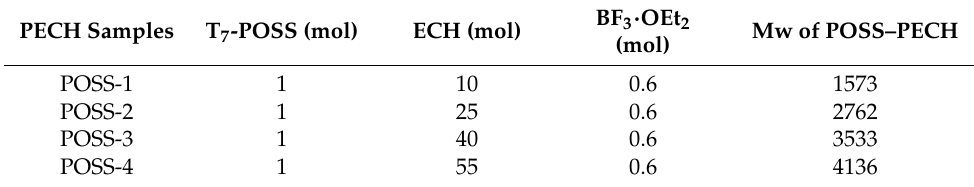
Figure 1. Synthetic route of POSS–PECH. Table 1. Feed molar ratio of POSS–PECH with different molecular weights.